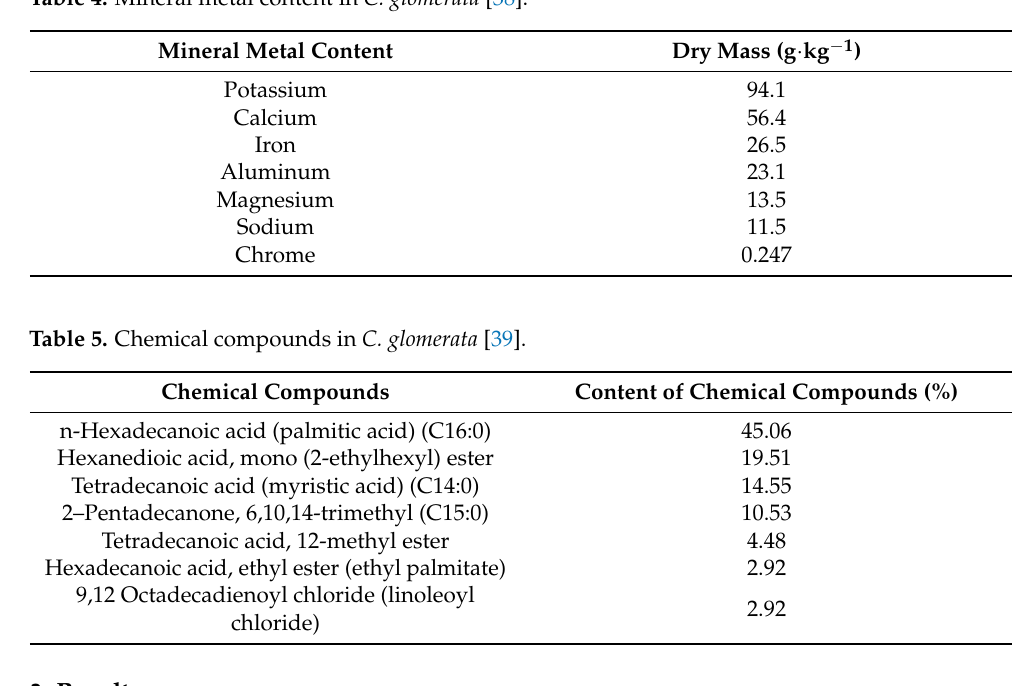
Table 4. Mineral metal content in C. glomerata [38].